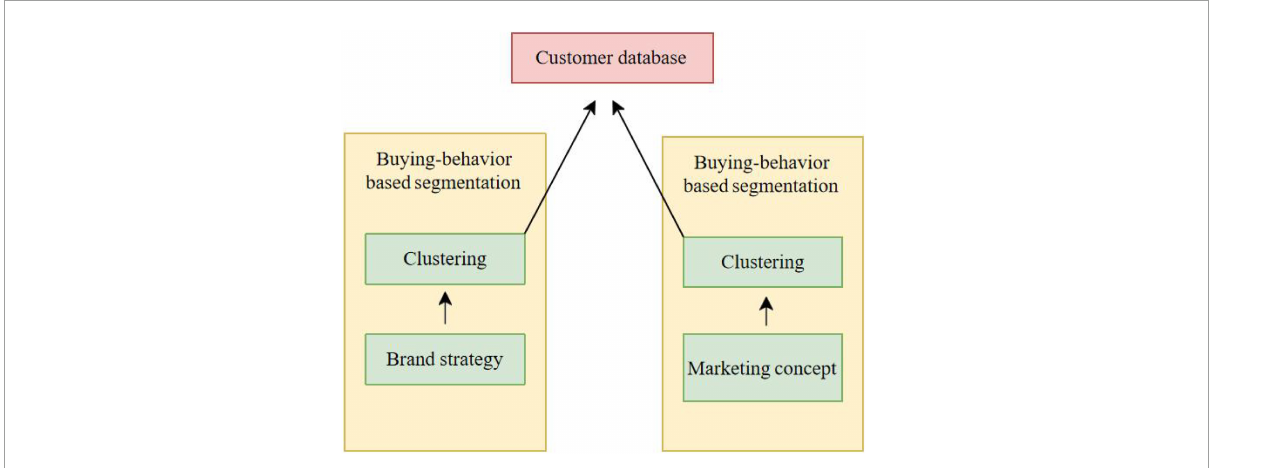
FIGURE1 Two types of input data that form user’s interest